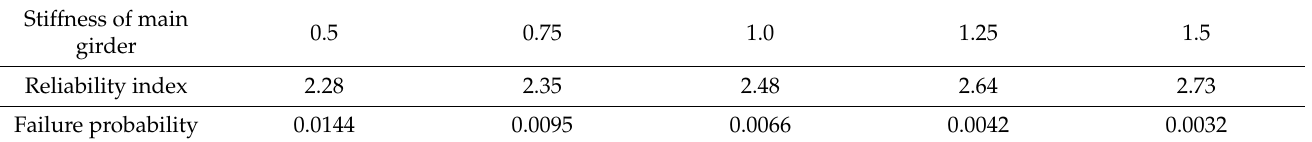
Table 11. Flutter failure probability corresponding to different stiffnesses of main girder.